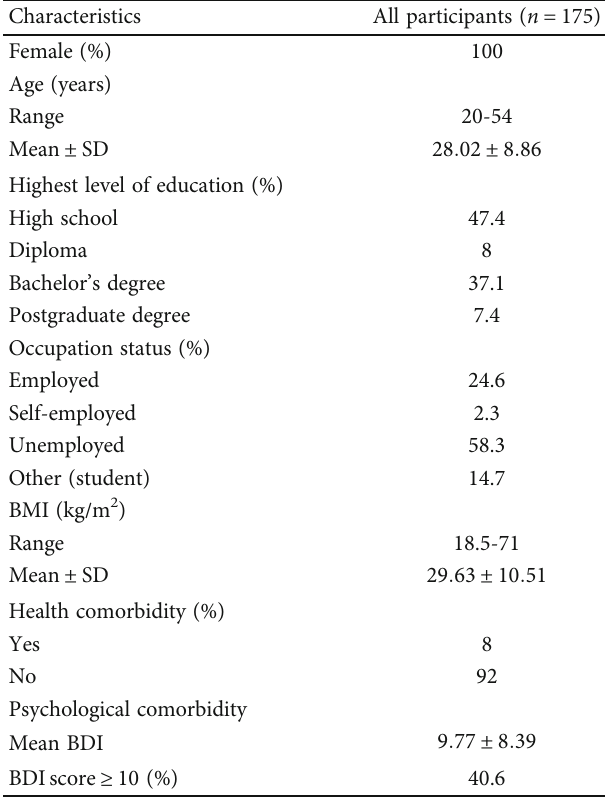
Table 1: Demographic and clinical characteristics of all the participants in the